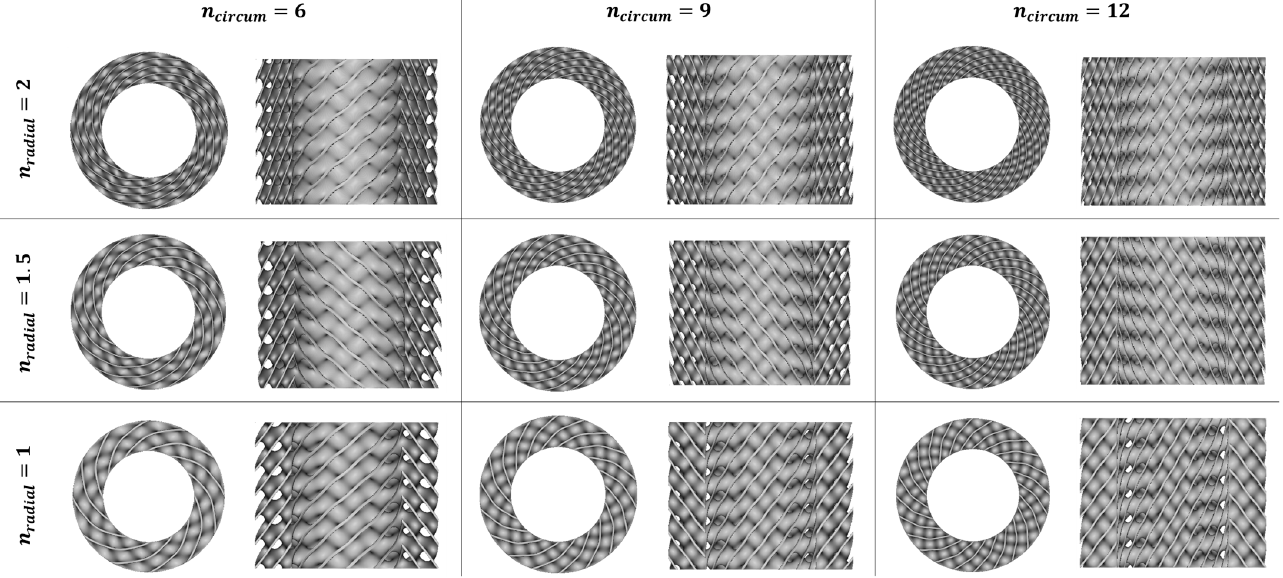
Figure 5. CAD models of Diamond TPMS cylindrical structures—top view and vertical cross-section.